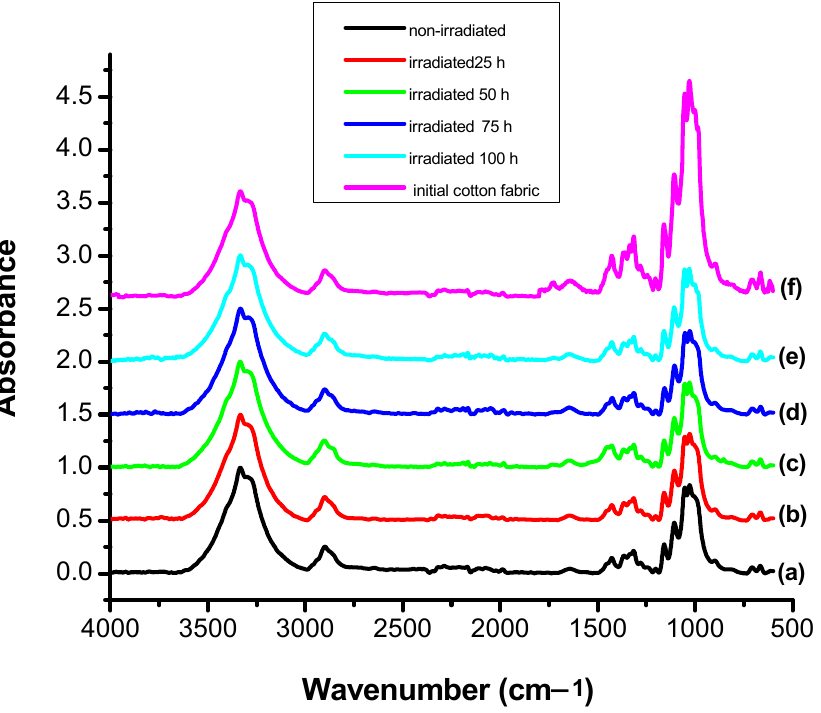
Figure 9. FTIR difference spectrum of the initial non-dyed cotton fabric (positive signals-upwards) and the cotton fabric dyed with RB_204 (negative signals-downwards).